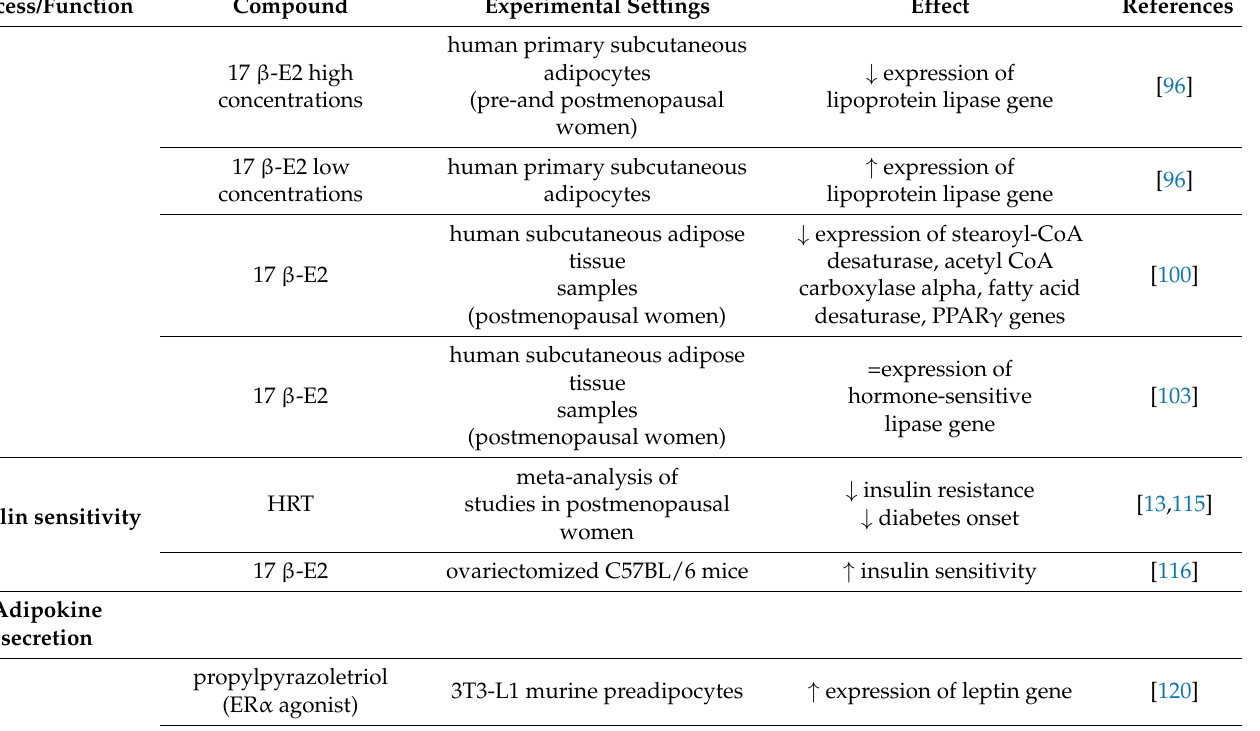
Table 2. Role of estrogens in the regulation of adipogenesis and adipose tissue